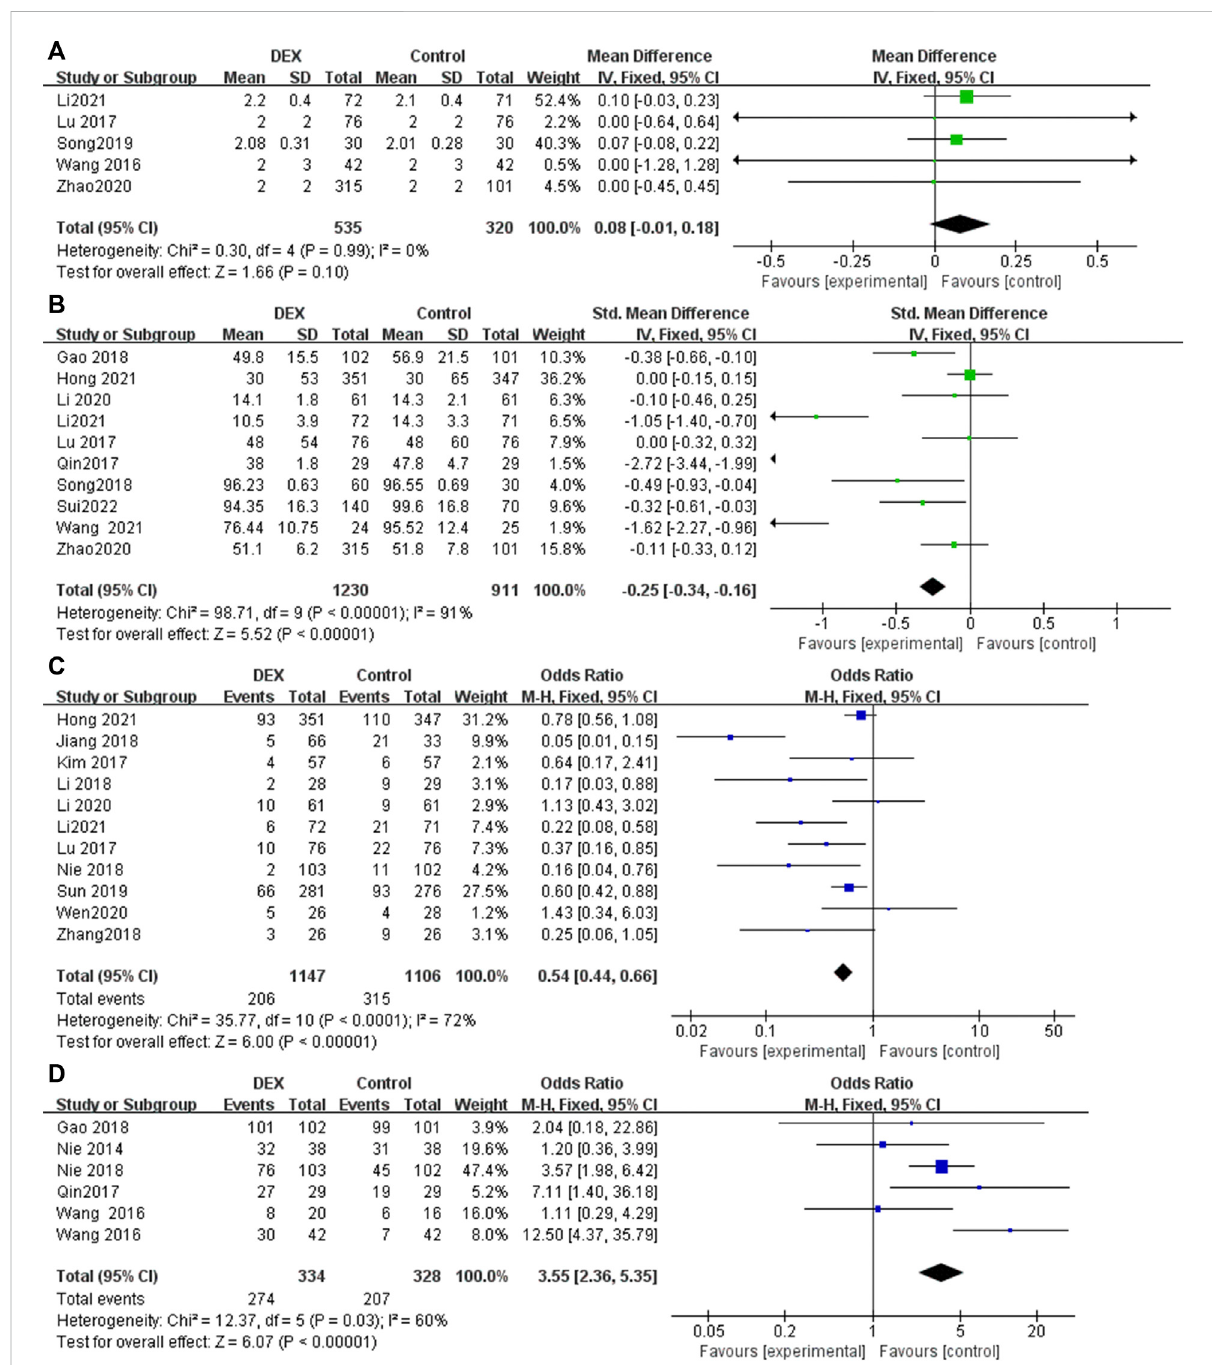
FIGURE 4 Forestplotforsedation,analgesicdrugconsumption,rescueanalgesiaandpatientsatisfactioninpostoperativePCIApatients. (A) Ramsayscore at 24 h postoperatively, (B) Total consumption of analgesics within 24 h, (C) Use of rescue analgesics, (D) Patient